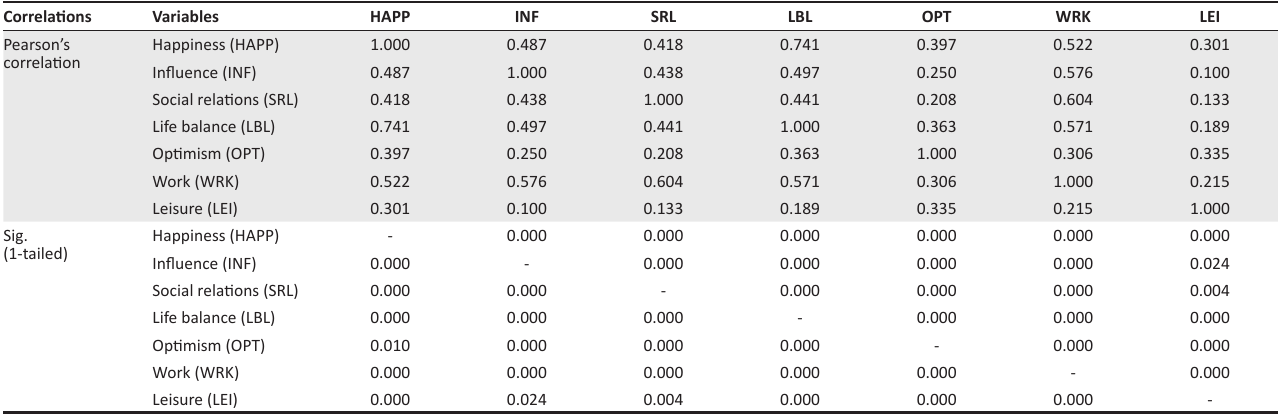
TABLE 4: Pearson’s correlations with p -values ( n = 395).